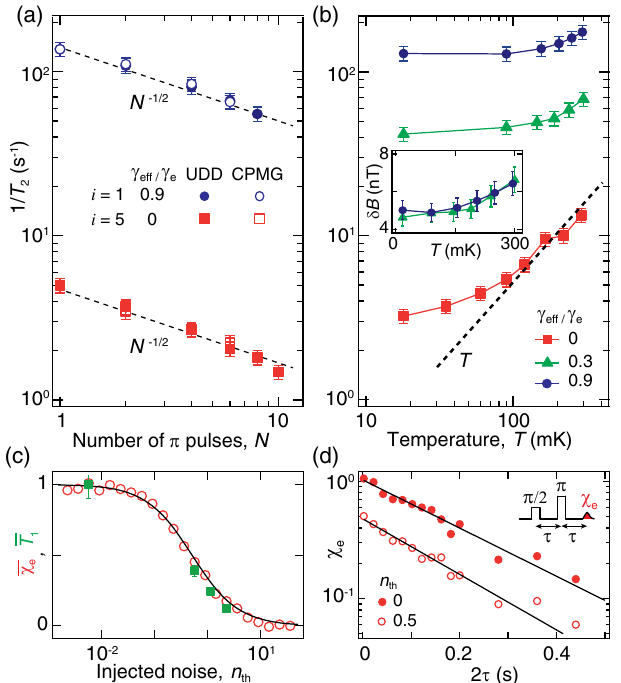
FIG. 7. Additional noise characterizations in Res1 at f Δ ¼ − 2 . 5 MHz (spins below the wire). (a) Echo decay rate 1 =T 2 as a function of the number of pulses in the dynamical decoupling sequence on transitions i ¼ 1 (blue) and i ¼ 5 (CT, red). Full (open) symbols correspond to the UDD (CPMG) sequence. The dashed line indicates the N − 1 = 2 scaling. (b) Echo decay rate 1 =T 2 as a function of sample temperature T for transitions i ¼ 1 (blue), i ¼ 4 (green), and i ¼ 5 (CT, red). The dashed line is a guide to the eye, suggesting a T − 1 scaling at high temperatures of the decay times at the CT. Inset: δ B ¼ 2 π = ð T 2 γ obtained by eff Þ subtracting the contribution from nonmagnetic noise (values measured at CT), as explained in the main text. (c) Normalized echo amplitude (circles) and spin relaxation time T 1 (squares) in the presence of injected thermal noise n . The symbols and line th are, respectively, measurements and theory from Eq. (9). (d) Echo integral χ as a function of the delay 2 τ at the i ¼ 5 transition e (CT), without (red dots) and with (red circles) injection of n th ¼ 0 . 5 photons of thermal noise. Solid lines are exponential fits to the data, and they show that the decay rate is not affected by thermal